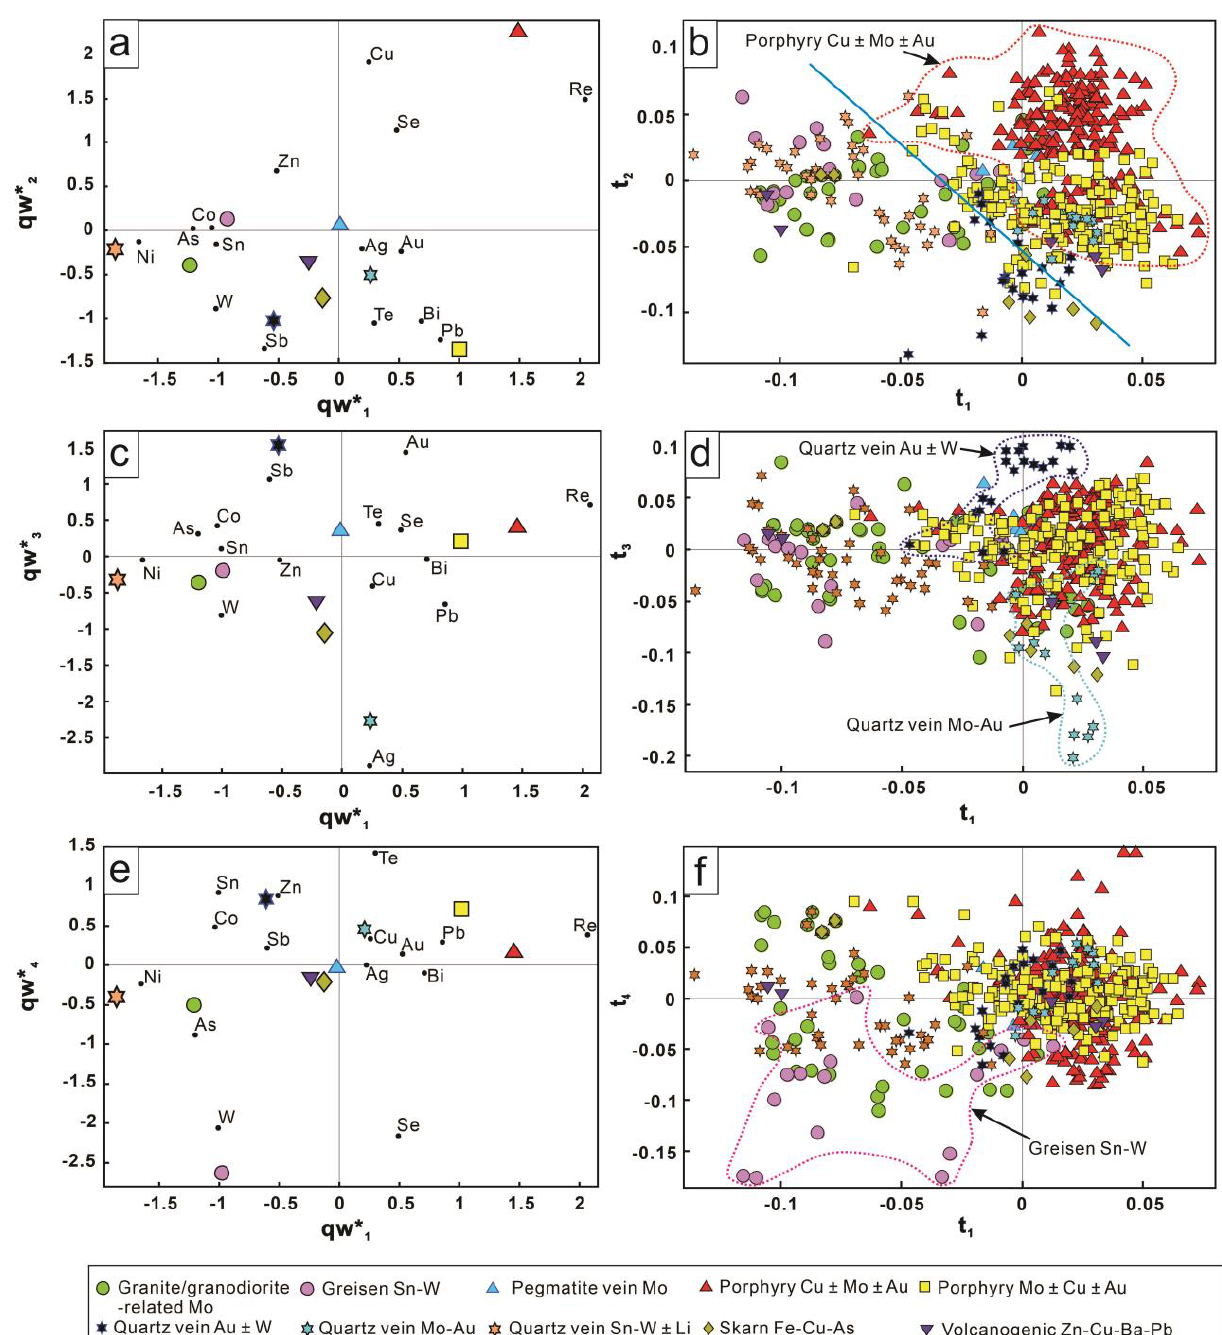
Figure 5. PLS-DA results of LA–ICP–MS data of molybdenite from ten deposit types. Plots of qw* 1 vs. qw* 2 ( a , first and second loadings), qw* 1 vs. qw* 3 ( c , first and third loadings), and qw* 1 vs. qw* 4 ( e , first and fourth loadings) showing correlations between elements and deposit types. Plots of t 1 vs. t 2 ( b , first and second scores), t 1 vs. t 3 ( d , first and third scores), and t 1 vs. t 4 ( f , first and fourth scores) showing the distribution of individual analyses of molybdenite in the latent variable space defined by qw* 1 – qw* 2 in ( a ), qw* 1 – qw* 3 in ( c ), and qw* 1 – qw* 4 in ( e ) respectively.